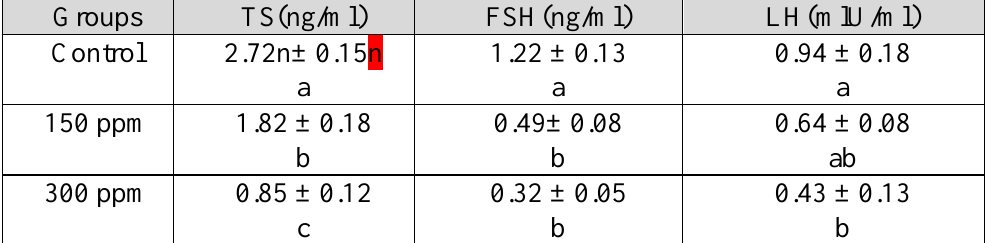
Table 6. Effects of sub lethal concentrations of sodium fluoride on sex hormone, mean ±